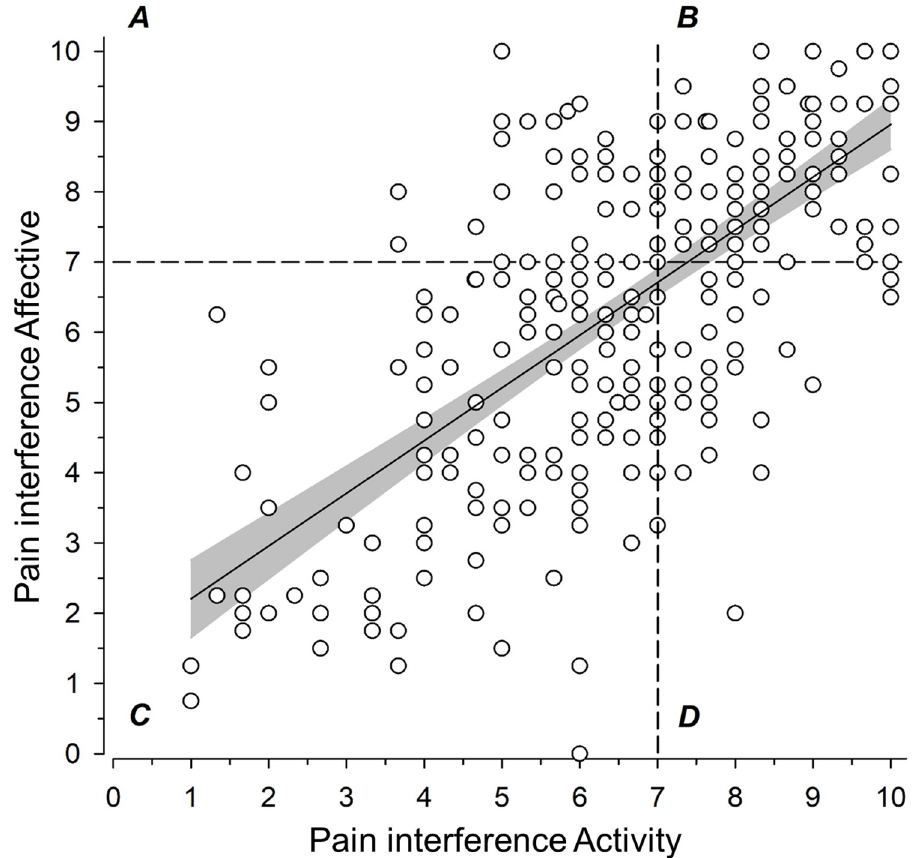
Fig 2. The subjects were allocated into four groups based on the activity and affective interference scores, using 7.00 as the cut-off value (0–10). A = activity low, affective high; B = activity high, affective high; C = activity low, affective low; D = activity high, affective low. Regression line with 95% confidence intervals shows the relationship between activity and affective interference (r 2 = 0.46, 95% CI: 0.37 to